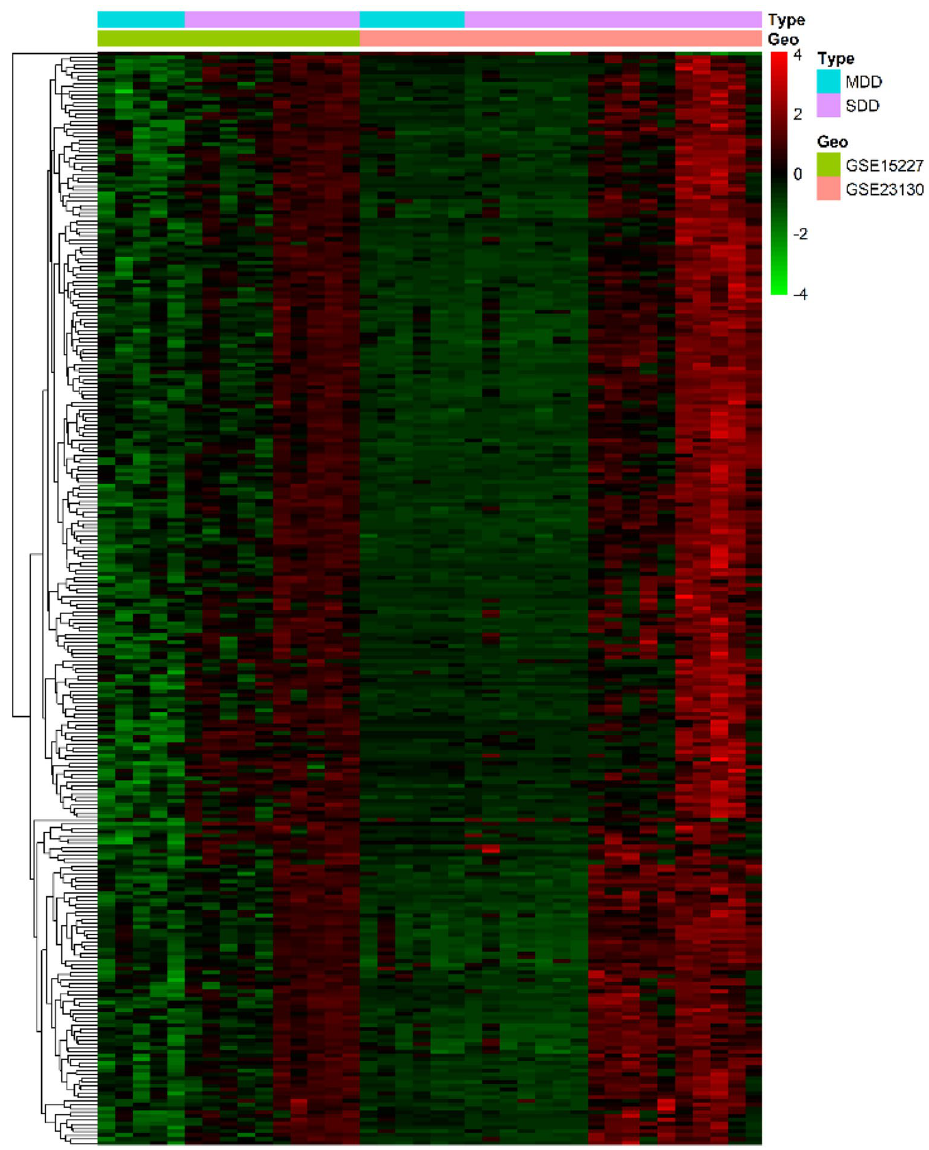
Figure 1. Heatmap of differential gene expression profiles in GSE15227 and GSE23130. The heatmap showed the similarity of the two datasets in SDD group and MDD group. Red represents up-regulated genes and green represents down-regulated